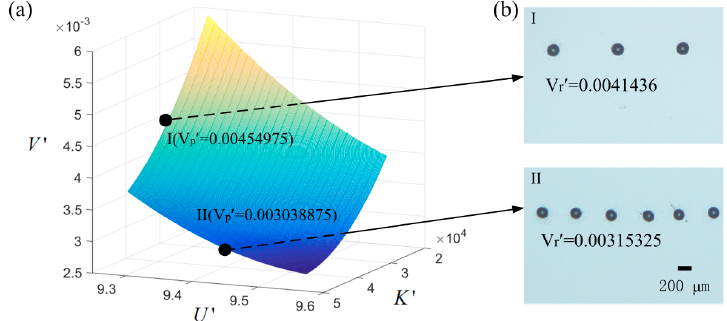
Figure 7. ( a ) A surface of the predicted dimensionless ejection volume of two points in the operation field: I ( K (cid:48) = 3.857 × 10 4 , U (cid:48) = 0.9228) and II ( K (cid:48) = 5.142 × 10 4 , U (cid:48) = 0.9358). µ (cid:48) = 0.4224 and H (cid:48) = 5.769 for the two cases. ( b ) The printed droplets on the substrate at the conditions of I and II. V p (cid:48) represents the predicted dimensionless ejection volume from the regression model. V r (cid:48) represents the real dimensionless ejection volume of the